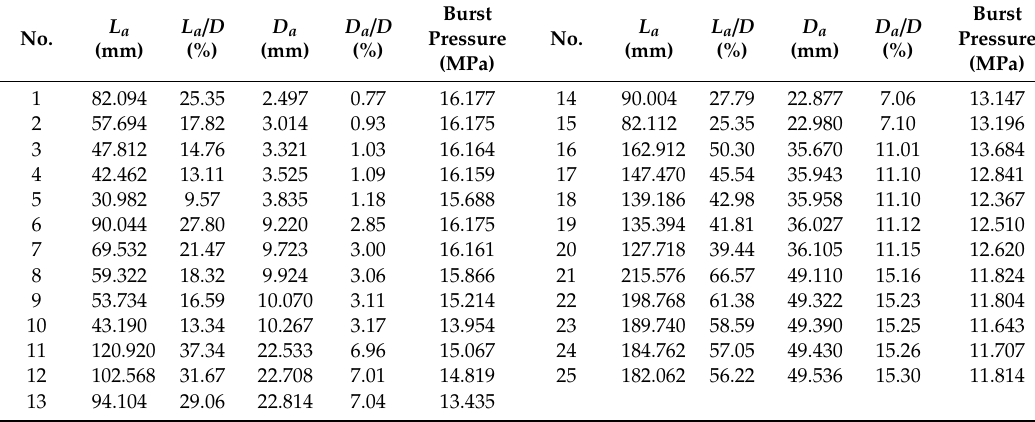
Table A3. La , La / D , Da , Da / D and burst pressure for the FEA based parametric study (II) for X65 material pipelines with a hemispherical dent.